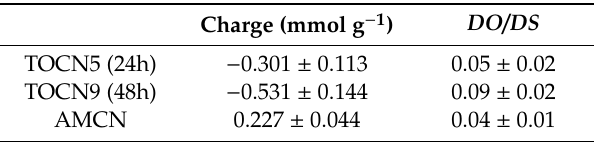
Table 1. Charge and degree of oxidation ( DO ) or degree of substitution ( DS ) values determined by conductometric titration of TEMPO-oxidized NFC (TOCN5 and TOCN9) and amine-modified NFC (AMCN).